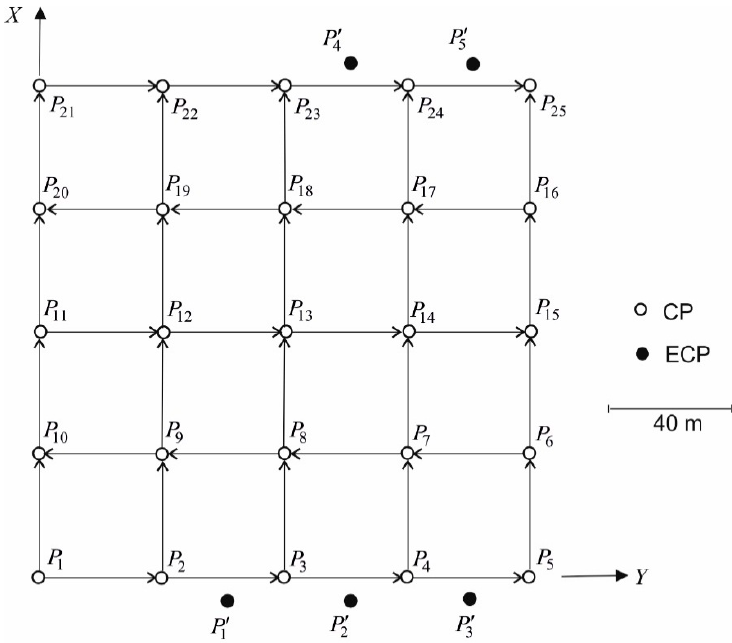
Figure 1. Simulated free control network. CP, controlled point; ECP, extended CP.